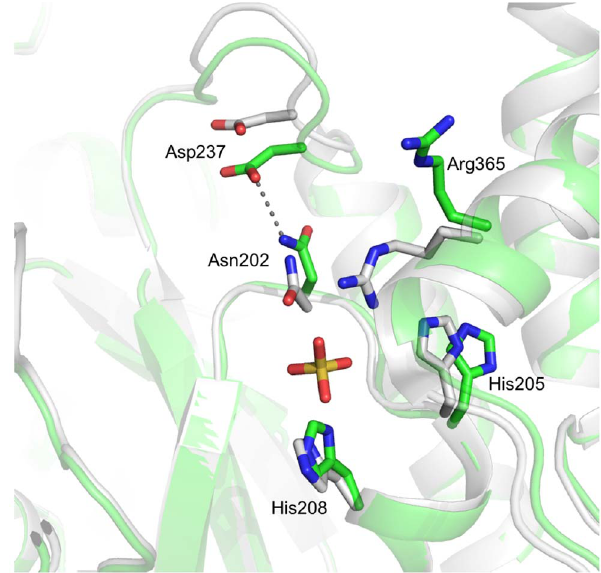
Figure 4. Pyrophosphate binding regions in A.vinosum (green) and of ‘‘ Candidatus E. persephone’’ (grey) ATPS. Phosphate binding found in ‘‘ Candidatus E. persephone’’ ATPS induces conforma- tional changes of His208 of the 205 HXXH 208 motif, Asn202 that influences the conformation of the ‘‘GxxKxxD’’ loop and of Arg365 that moves into the PP i binding site.